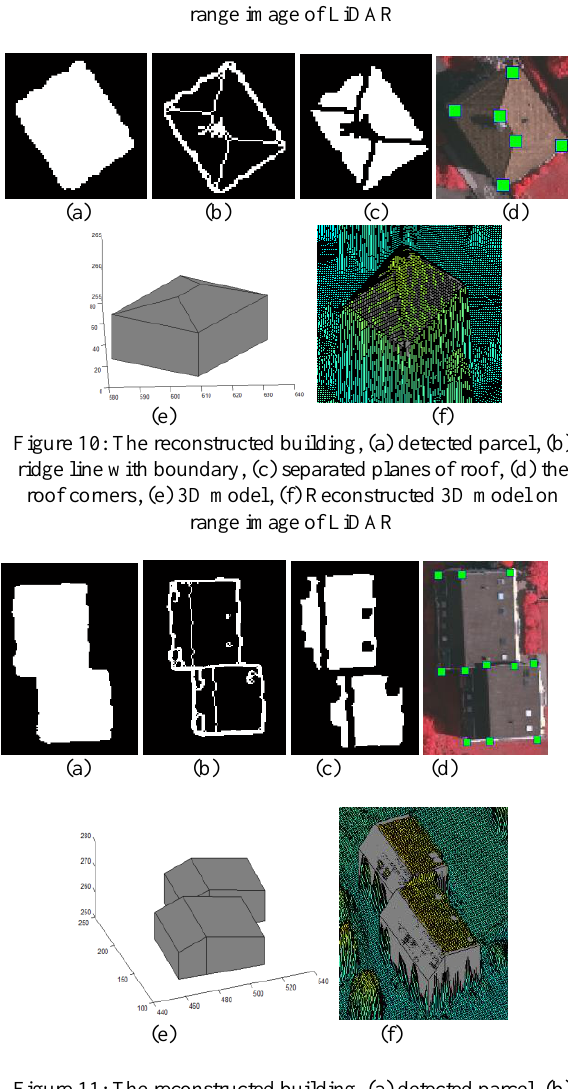
Figure 9: The reconstructed building, (a) detected parcel, (b) ridge line with boundary, (c) separated planes of roof, (d) the roof corners, (e) 3D model, (f) Reconstructed 3D model on